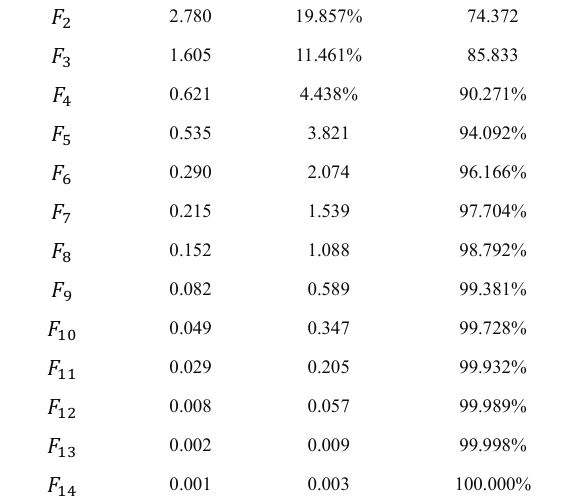
Table 4. Contribution probability and cumulative contribution